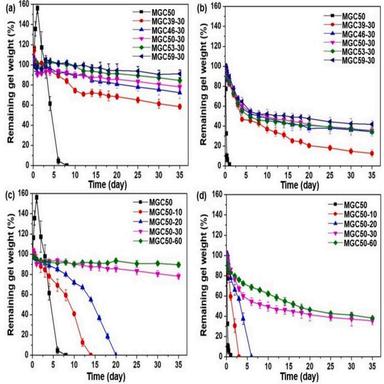
(a) Physical stability of photo-crosslinked MGC thermogels with different substitution ratios. (b) Enzymatic degradation profiles of photo-crosslinked MGC thermogels. (c) Physical stability of photo-crosslinked MGC50 thermogels with different UV irradiation times. (d) Enzymatic degradation profiles of photocrosslinked MGC50 thermogels with different UV irradiation times.